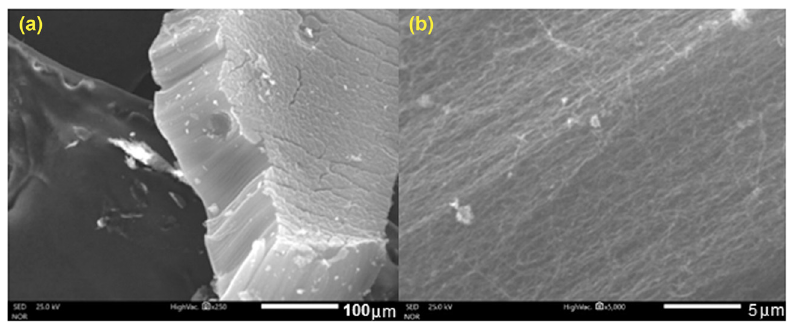
Figure 6: SEM images of unmodi fi ed CNTs: ( a ) magni fi cation × 250; ( b ) magni fi cation × 5,000.